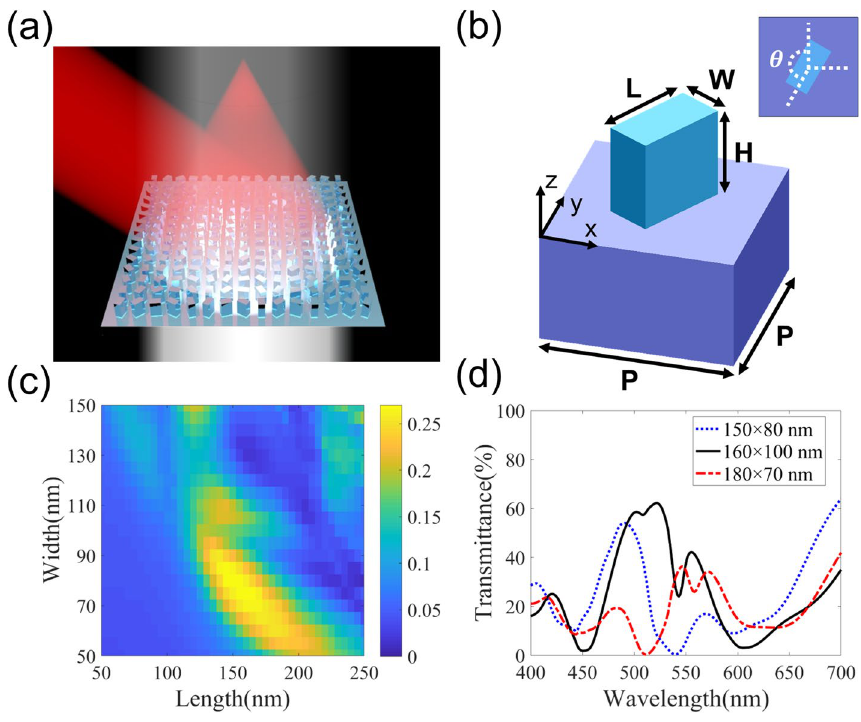
Fig. 2 Schematics of the metalens. ( a ) Schematic illustration of the optical behavior of the proposed see‑through reflective metalens. ( b ) Schematic illustration of a unit cell of the metalens, consisting of a Si nanofin on the sapphire substrate with fixed length L, width W, height H, and period P, but varying rotation angle θ according to the Pancharatnam‑Berry phase. ( c ) 1st order diffraction efficiencies of the reflected light, as the length and width of the nanofins vary while the height is fixed to be 230 nm. ( d ) 0th order transmission spectra of the meta‑grating‑cell, with the corresponding length width of each nanofin labeled in the ×